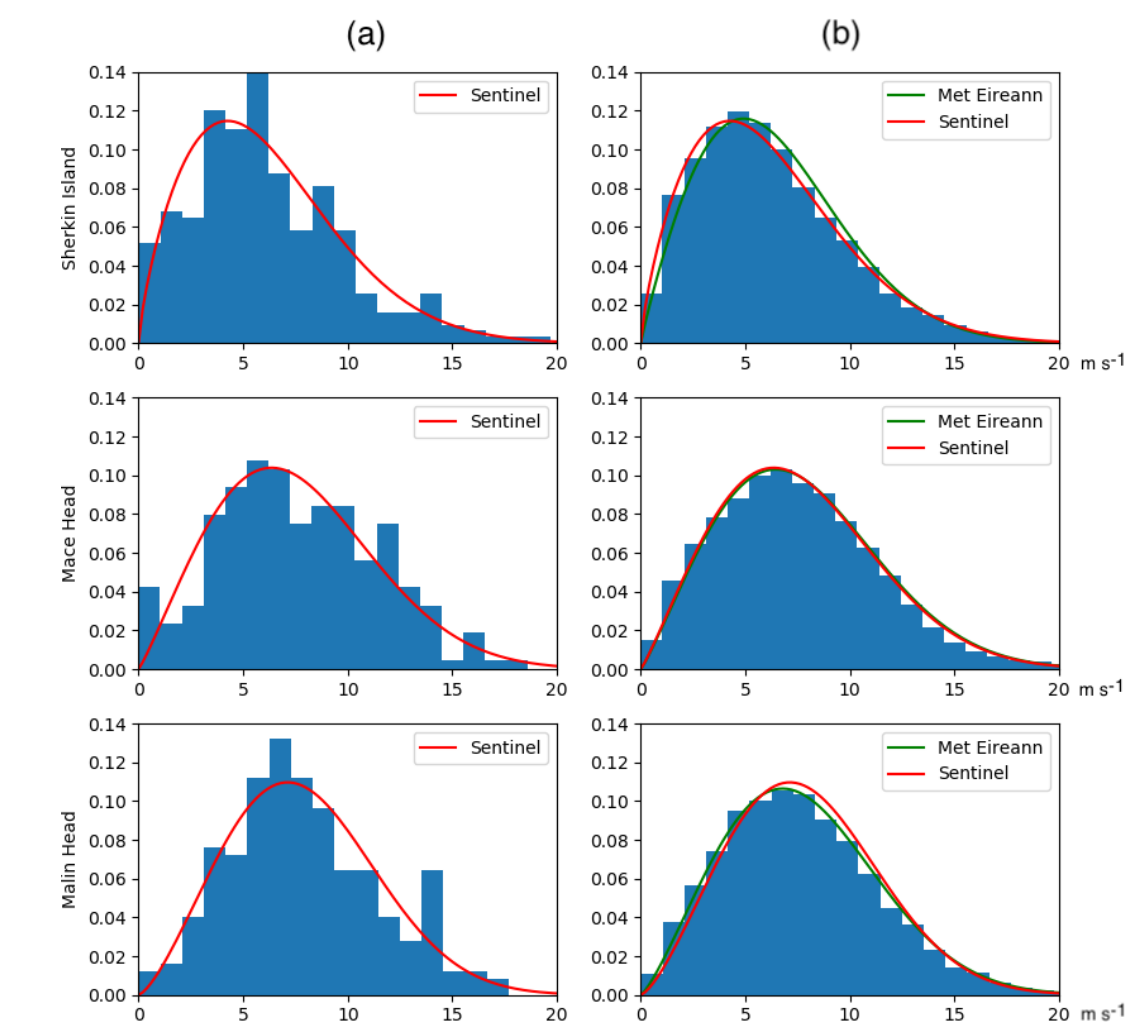
Figure 6. Wind speed histograms of Sentinel-1 SAR Level 2 OCN with Weibull fit (red curves) (a) . Wind speed histograms of in situ coastal weather station data at the same locations with Weibull fits (green curves) (b) . The Weibull fits of satellite data (red curves) have been reproduced over the corresponding coastal weather station data (b) to allow a visual comparison with their Weibull fits in green. Table 6. Comparison of wind speed long-term statistics obtained from the four weather buoys with the ones obtained from the SAR data. These values are the results of the match-up comparison exercise and are used to evaluate the accuracy of the satellite data. Buoy k k (in λ λ (in Wind Wind %